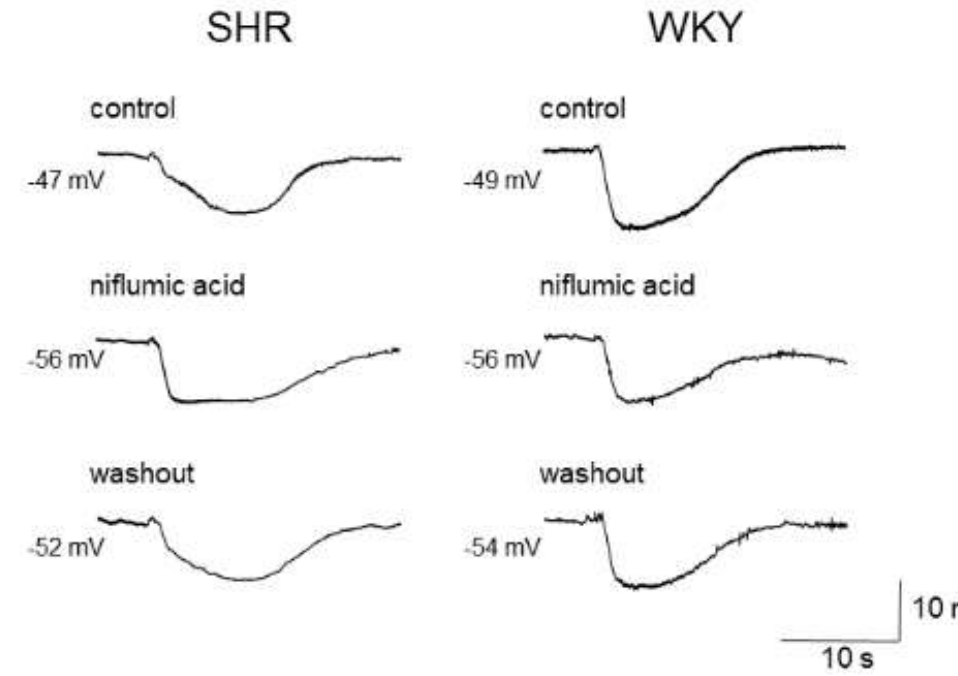
Figure 2. Effects of niflumic acid on acetylcholine-induced, endothelium-dependent hyperpolariza- tion (EDH) in mesenteric arteries of spontaneously hypertensive rats (SHRs) and Wistar Kyoto (WKY) rats. Niflumic acid (50 µ mol/L) improved EDH in SHRs but not in WKY rats. Each paired recording was from the same preparation. Indomethacin (10 µ mol/L) and N ω -nitro-L-arginine methyl ester (100 µ mol/L) were present throughout. Table 2. Alterations in vascular endothelial Ca 2+ -activated Cl − channels during hypertension.